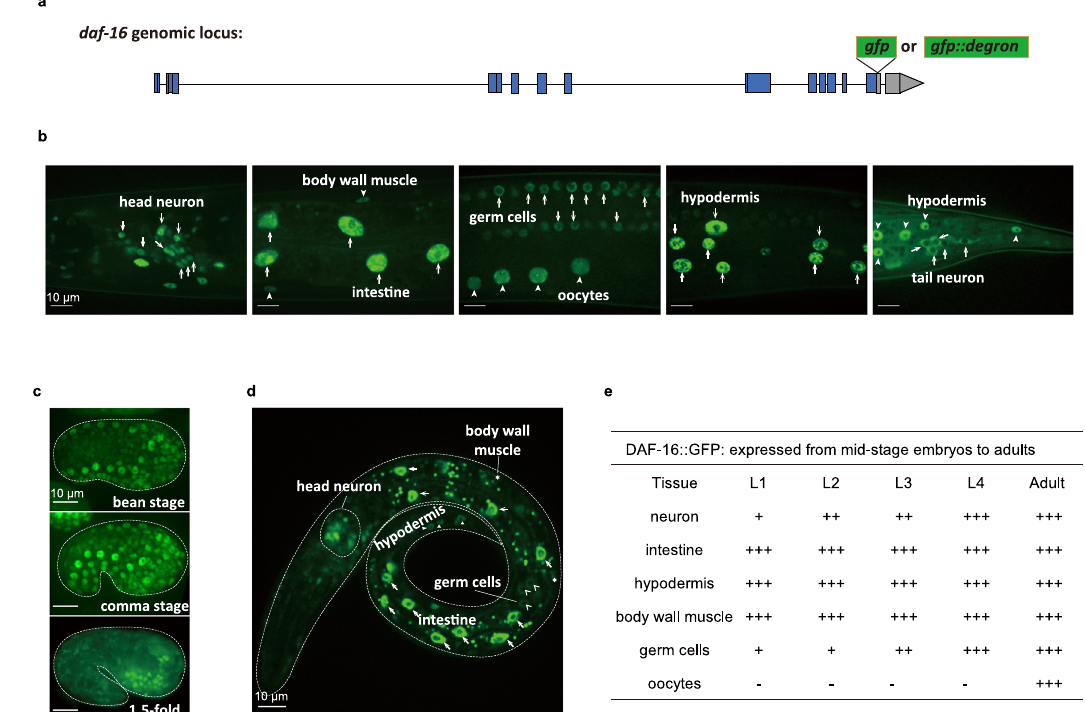
Fig. 2 | Ubiquitous presence of DAF-16 detected in the C. elegans soma and germline. a Schematic of knocking in the coding sequence of GFP or GFP::degron into the daf-16 genomic locus before the stop codon using CRISPR/Cas9 genome editing. Blue boxes, coding regions; line, non-coding regions; gray boxes, 3 ’ untranslatedregions.ExpressionpatternsofDAF-16::GFPatday1of adulthood ( b